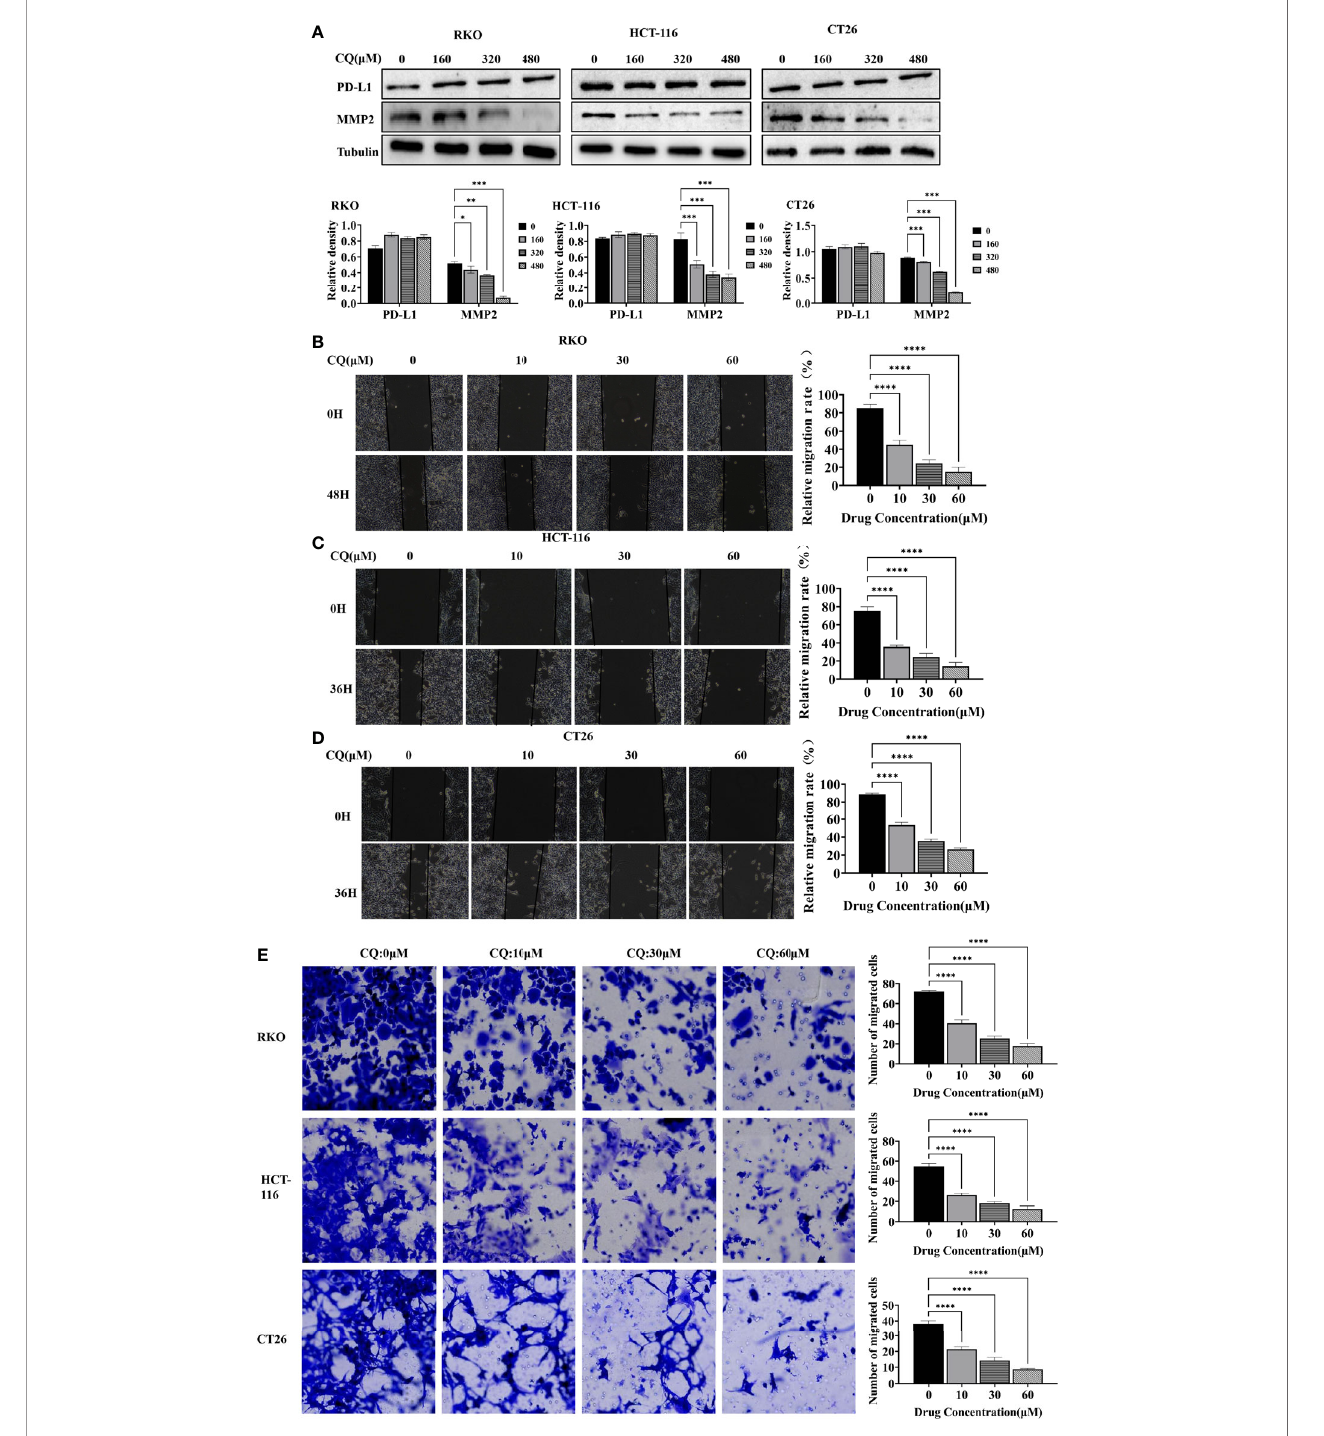
FIGURE 3 | Chloroquine inhibits migration of colorectal cancer cells. (A) Western blotting analysis for the protein expression of PD-L1, MMP2 after treatment with a chain of concentrations of CQ. (B – D) Wound healing assay detects the effect of different concentrations of CQ on the migration ability of colorectal cancer cells RKO, HCT-116 and CT26. (E) Transwell assay detects the effects of different concentrations of CQ on the migration ability of colorectal cancer cells RKO, HCT-116 and CT26. (* p < 0.05, ** p < 0.01, *** p < 0.001, **** p < 0.0001 vs 0 m M